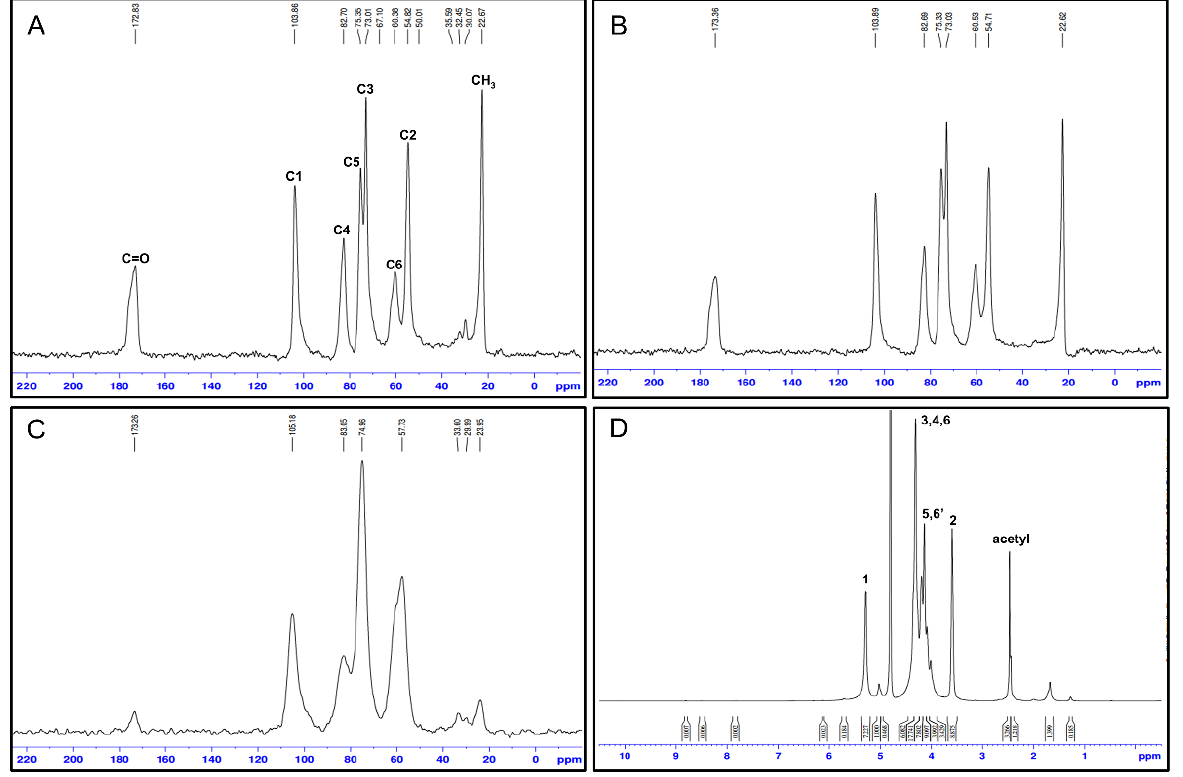
Figure 2. Nuclear magnetic resonance (NMR) data of chitin and chitosan. 13 C NMR data of mealworm chitin ( A ), shrimp chitin ( B ), and mealworm chitosan ( C ). 1 H NMR data of mealworm chitosan ( D ).